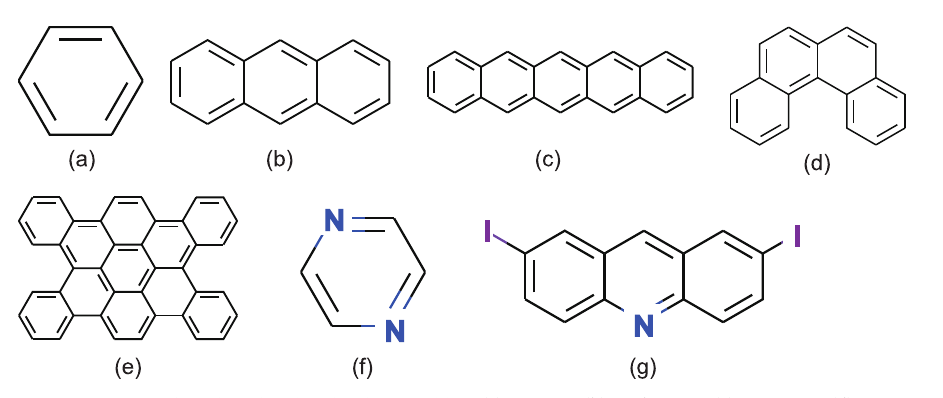
Fig 9. Structures of single isolated molecules in Table 2. (a) Benzene. (b) Anthracene. (c) Pentacene. (d) Benzophenanthrene. (e) Tetrabenzocoronene. (f) Pyrazine. (g) 2,7-bisacridine.